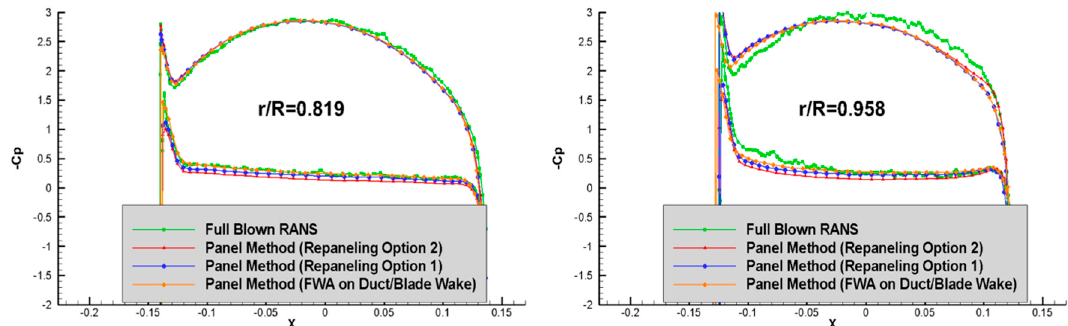
Figure 15. Correlation of the pressure coefficients predicted by the present method, with cylindrical duct wake, Options 1 or 2, and fully aligned duct wake (FWA), and from RANS at several blade sections. The radial location of each blade section is indicated in the figures.